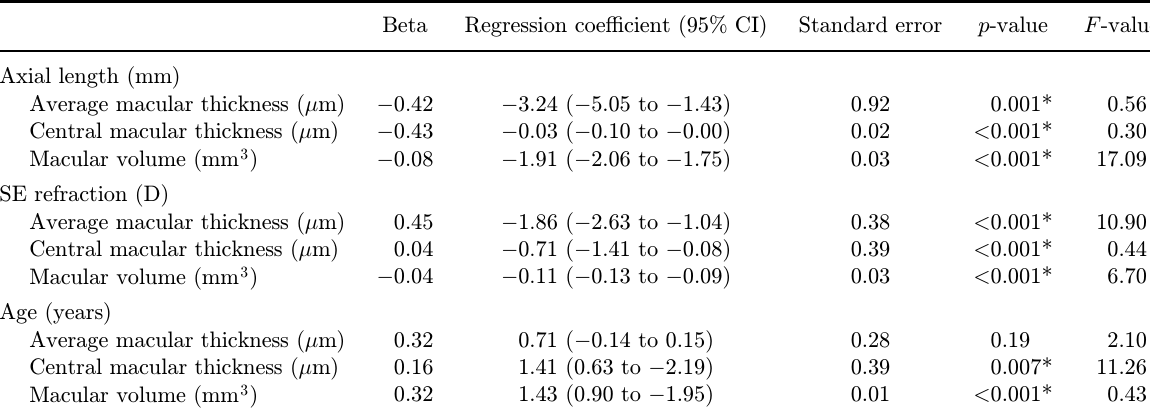
Table 5. Results of multivariate-mixed model analysis of the association between AL, SE and age and average macular thickness, central macular thickness and macular